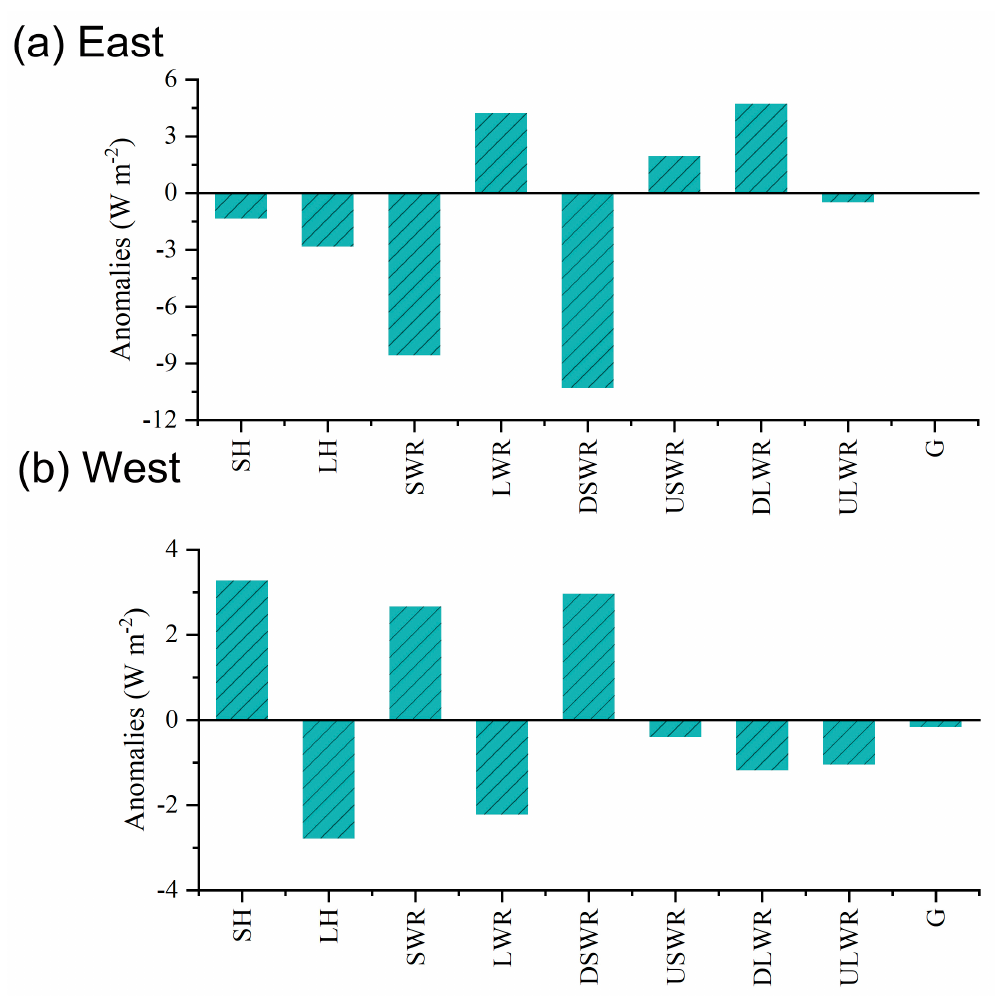
Figure 8. Anomalies in the interannual component of SH, LH, SWR, LWR, DSWR, LSWR, DLWR, ULWR, and G regressed on PC2-IA (W m − 2 ) in the region of eastern TP ( a ) and western TP ( b